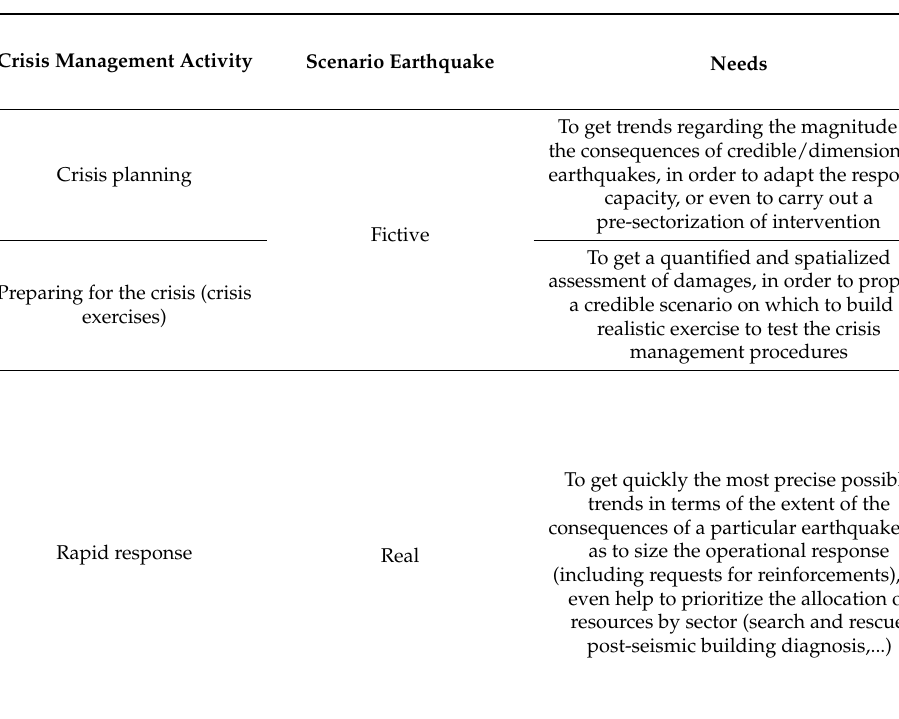
Table 9. Examples of damage scenarios that need to be related to crisis management activities, with qualitative assessment of corresponding required level of